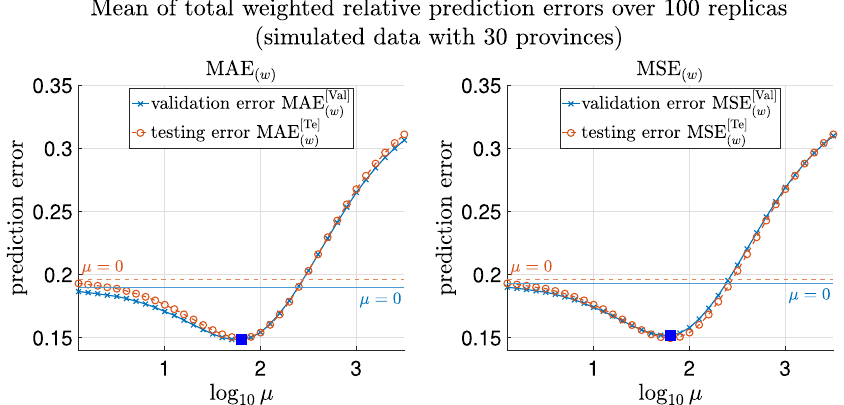
Figure 7. Testing and validation errors on simulated data with thirty provinces. Testing and validation errors [ V al ] on simulated data with four provinces. Left: The weighted prediction errors on validation set (MAE ( w ) ) and [ T e ] µ . The errors are averaged over 100 replicas of testing set (MAE ( w ) ) respectively, plotted vs. the values of experiment. Right: Same plot of MSE error. In each plot, the blue and red horizontal lines show the values of the averaged errors when µ = 0 . Note that both the MAE and MSE validation errors are minimized at µ ∗ = 10 1.8 , which is marked by blue squares in both plots. The construction of training/validation/testing data is detailed in Sect. A.1.1 of Supplementary Information, and the formulas of computing the errors can be found in Sect. B of Supplementary